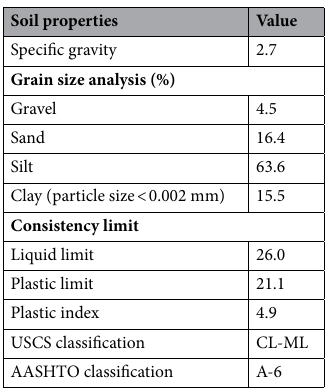
Table 1. Soil properties.